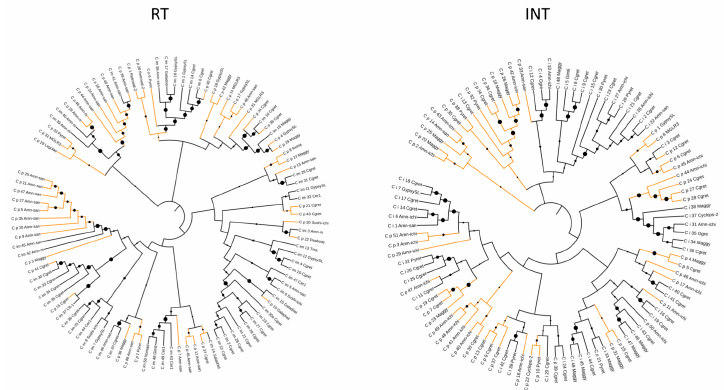
Figure 1. Phylogenetic relationship between RT and INT domains in C. immitis and C. posadasii . The black lines represent C . immitis Gypsy RT and INT domains; the orange lines represent C . posadasii Gypsy RT and INT domains. The size of the black dot represents the bootstrap value.